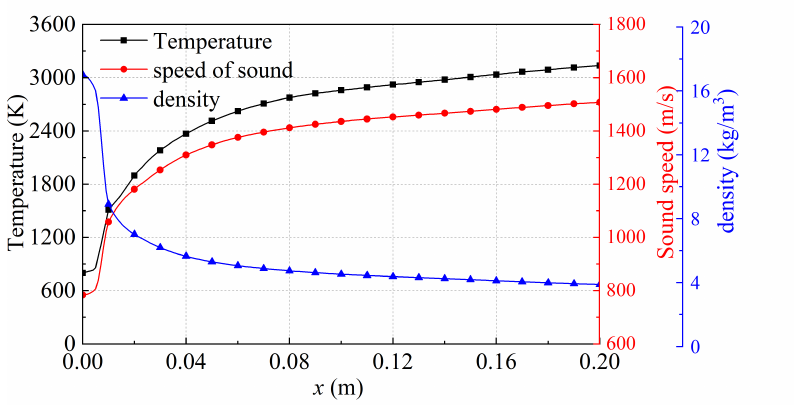
Figure 4. Mean flow properties along the axis of the BKD combustion chamber obtained by the RANS